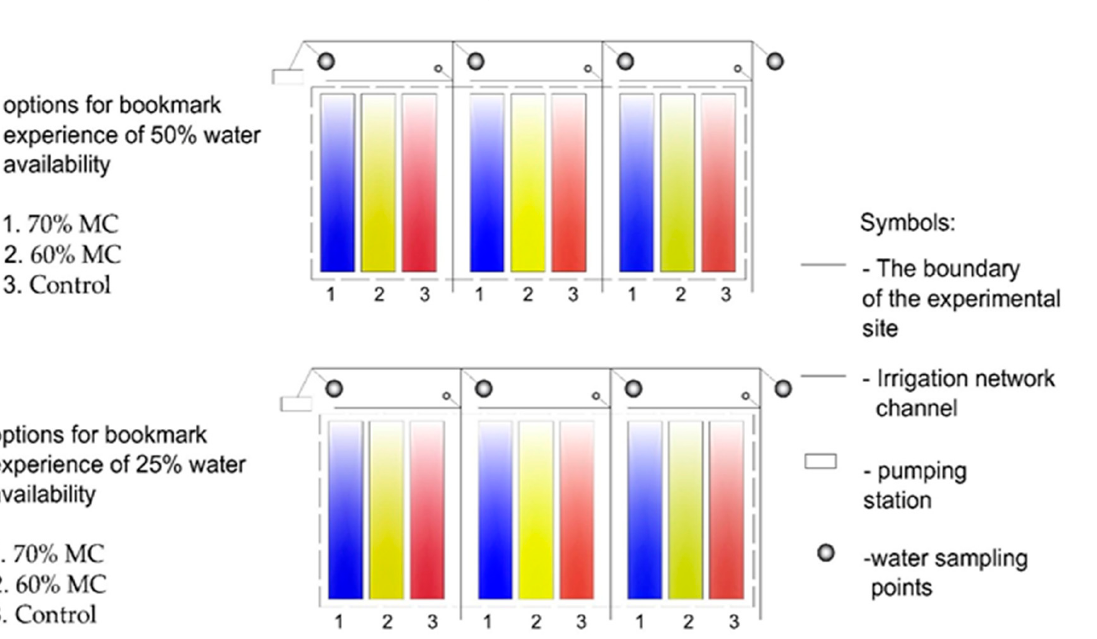
Figure 3. Scheme of the bookmark of experience on the farm “Sergey” cultivated spring wheat.